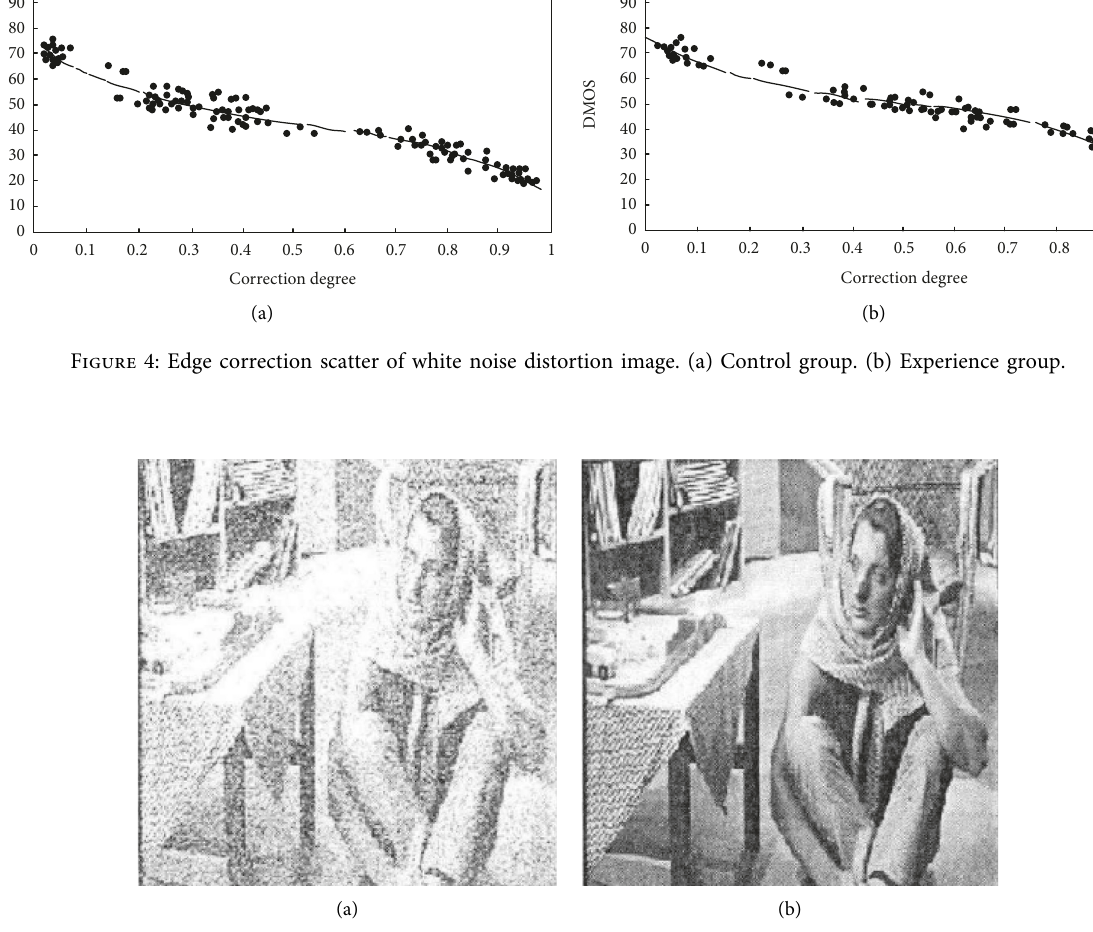
Figure 5: Correction effect. (a) Fast fading distorted image. (b) Corrected image.